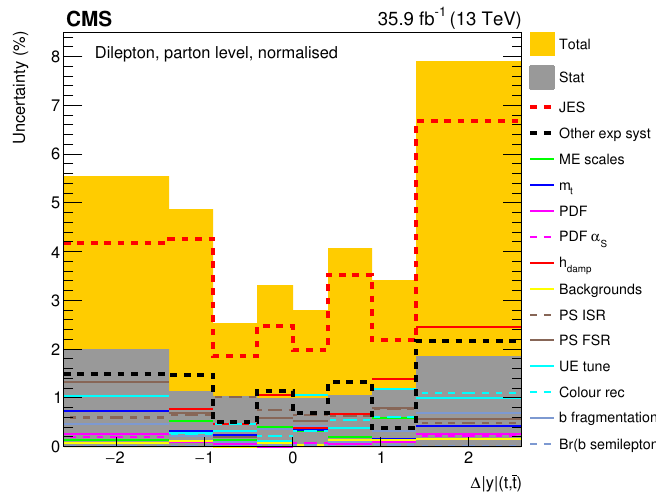
Figure 22 . The contributions of each source of systematic uncertainty to the total systematic uncertainty in each bin is shown for the measurement of the normalised tt production cross sections as a function of (cid:1) j y j (t ; t). The sources a(cid:11)ecting the JES are added in quadrature and shown as a single component. Additional experimental systematic uncertainties are also added in quadrature and shown as a single component. Contributions from theoretical uncertainties are shown